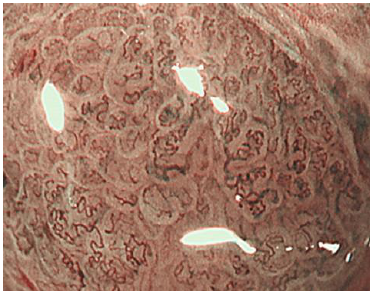
Figure 8. The loop pattern suggests tubular adenocarcinomas.